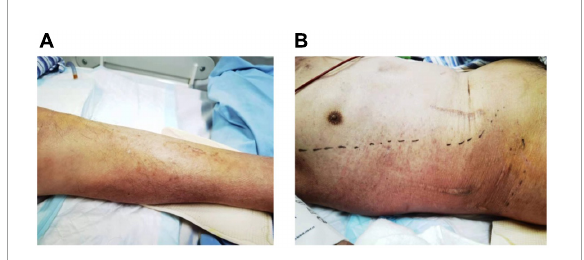
FIGURE1 Skin congestion and swelling on the left calf (A) on admission, and right chest wall (B) 5 days after admission.